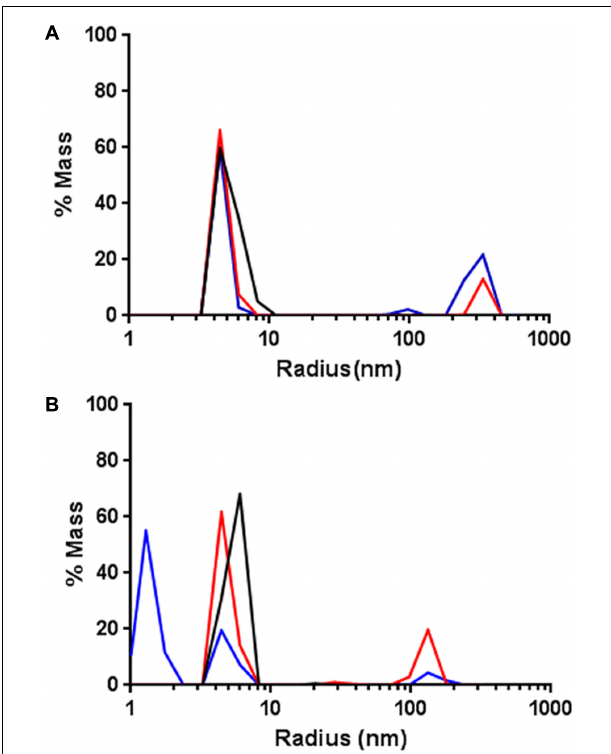
FIGURE 4 | AlpA– alpS nucleoprotein complexes stabilize AlpC filament formation. (A) Addition of pre-bound mCherry–AlpA– alpS complexes does not result in GFP-AlpC de-polymerization, but rather stabilizes the GFP-AlpC polymer fraction. Black lines indicate GFP-AlpC without ATP, red lines show GFP-AlpC with ATP, and blue lines indicate polymerization of GFP-AlpC in presence of mCherry–AlpA– alpS complexes. (B) Addition of a pre-bound scrambled mCherry-AlpA-scrambled- alpS mixtures results in depolymerization of GFP-AlpC polymers. Color code is as in (A) with blue line showing the effect of mCherry-AlpA with scrambled- alpS.